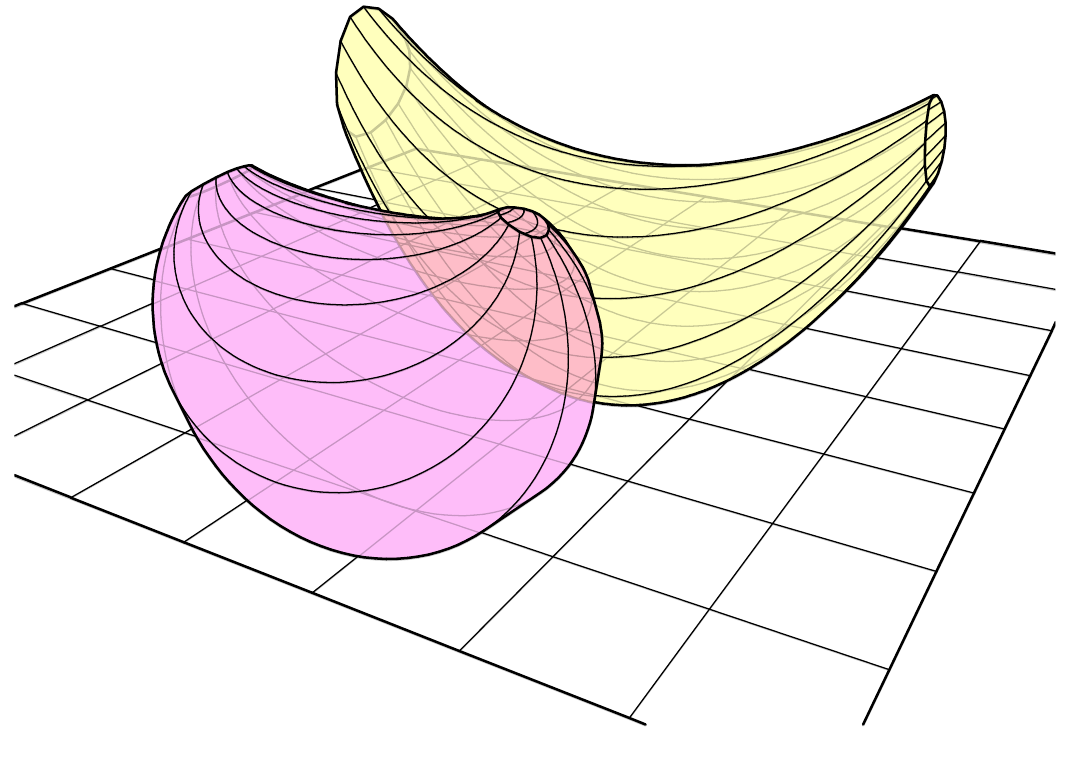
Figure 23. Developed surfaces before and after a perspective homography transformation. The rear shape was created using method three. The transformed developable surface at the front is not possible to create directly through any of the five methods discussed previously.